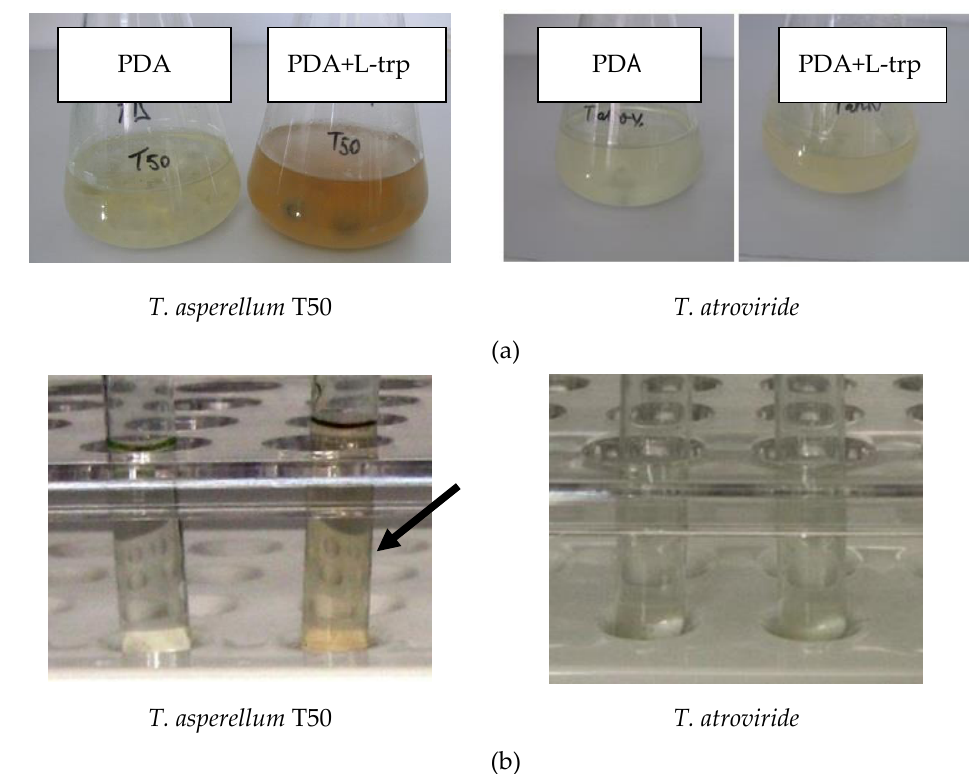
Figure 3. Qualitative test for IAA production by Trichoderma isolates. Pictures showed the changing color as a marker of IAA production. ( a ) PDA medium with or without L-tryptophan (L-trp). ( b ) visualization of pink color appearance (arrow) after adding ortho-phosphoric